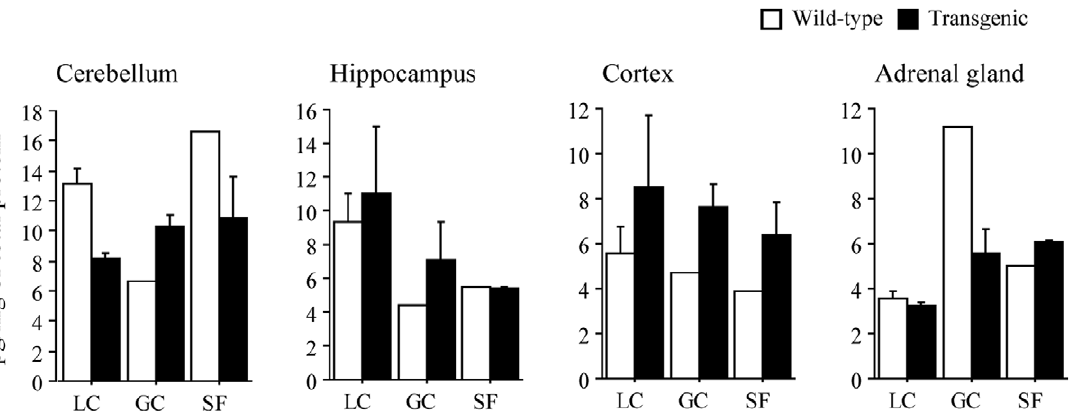
Figure 2. Responses of brain derived neurotrophic factor in brain and adrenal gland. See Figure 1 for the abbreviations and number of mice in each group. Mean 6 SEM.